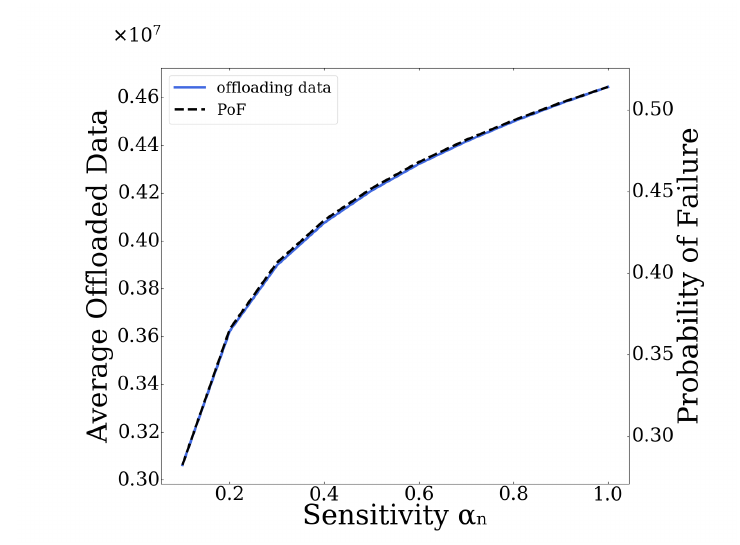
Figure 12. Average offloading data and PoF vs. sensitivity parameter α n